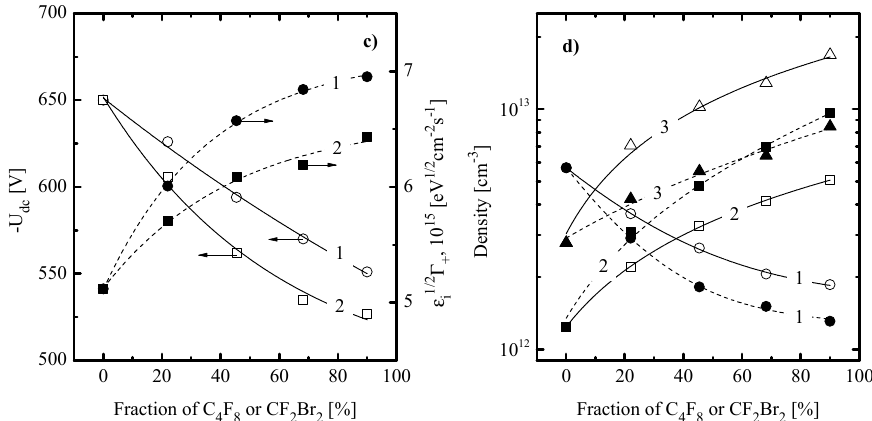
Figure 1. Effect of gas mixing ratios on SiO x N y etching kinetics ( a ) and plasma characteristics ( b – d ) at 𝑝 = 10 mTorr, 𝑊 = 100 W and 𝑦 (cid:3016) = 10%: ( a ) etching rate and effective reaction probability; ( b ) electron temperature and ion current density; ( c ) negative dc bias and the parameter (cid:3493)𝜀 (cid:3036) Γ (cid:2878) characterizing ion energy flux; and ( d ) atoms and radical densities. In ( a – c ), numerical labels on curves relate to CF 4 + C 4 F 8 + O 2 (1) or CF 4 + CF 2 Br 2 + O 2 (2) plasmas. In Figure ( d ), labels on curves relate to F (1), CF (2) and CF2 (3) species in CF 4 + C 4 F 8 + O 2 (solid lines) or CF 4 + CF 2 Br 2 + O 2 (dashed lines).